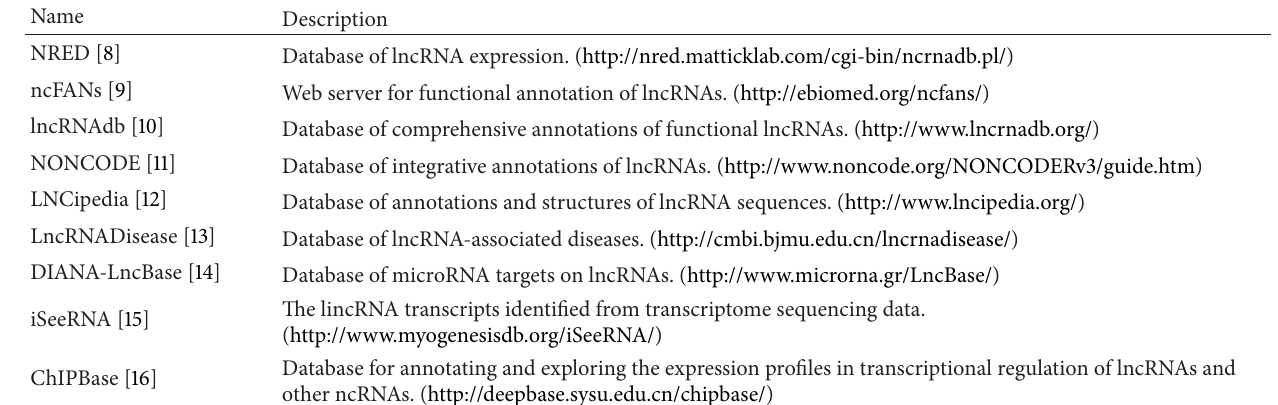
Table 1: The lncRNA bioinformatics